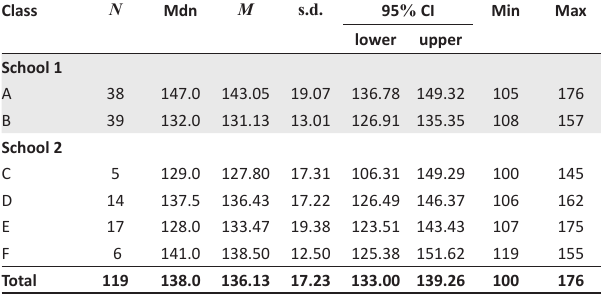
TABLE 4: Descriptive statistics for trait emotional intelligence by class.